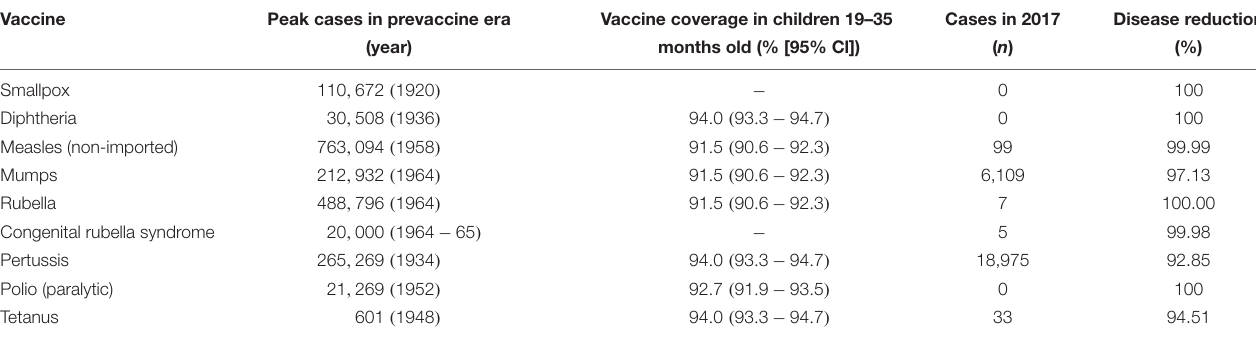
TABLE 1 | Vaccine impact in United States comparing the incidence of diseases prior to the implementation of vaccine (Roush and Murphy, 2007), described as the pre-vaccine era and the vaccine coverage (Hill et al., 2017) and disease incidence (Centers for Disease Control and Prevention, 2017) in 2017, as reported by the Centers for Disease Control and